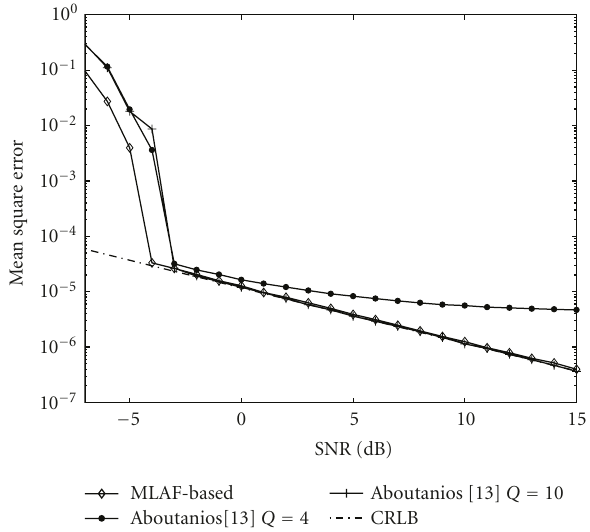
Figure 4: Comparison with other autocorrelation-based estima- tors. Signal frequency randomly distributes between [0,0 . 8 π ]. N = 256. For the MLAF-based estimator, q = 4 and τ = 1.